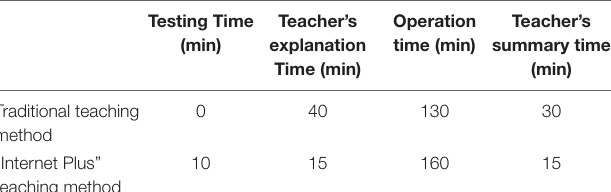
TABLE 1 | Comparisons between traditional teaching method and “Internet Plus” teaching method.